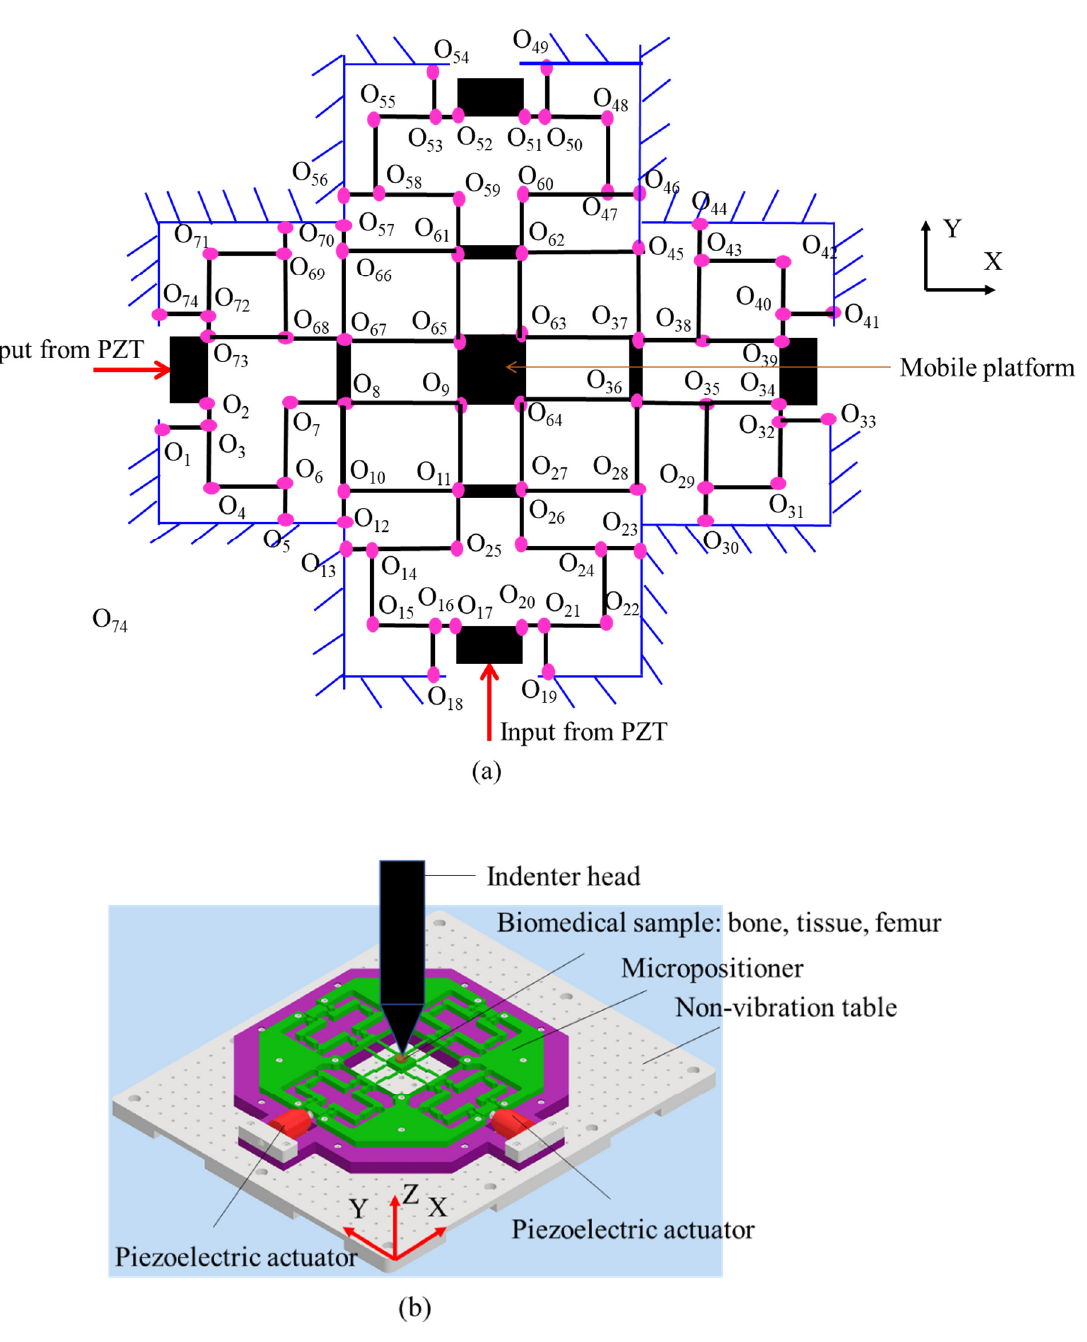
Figure 1. XYZ micropositioner for nanoindentation: ( a ) Kinematic scheme and ( b ) basic application for nanoindentation.